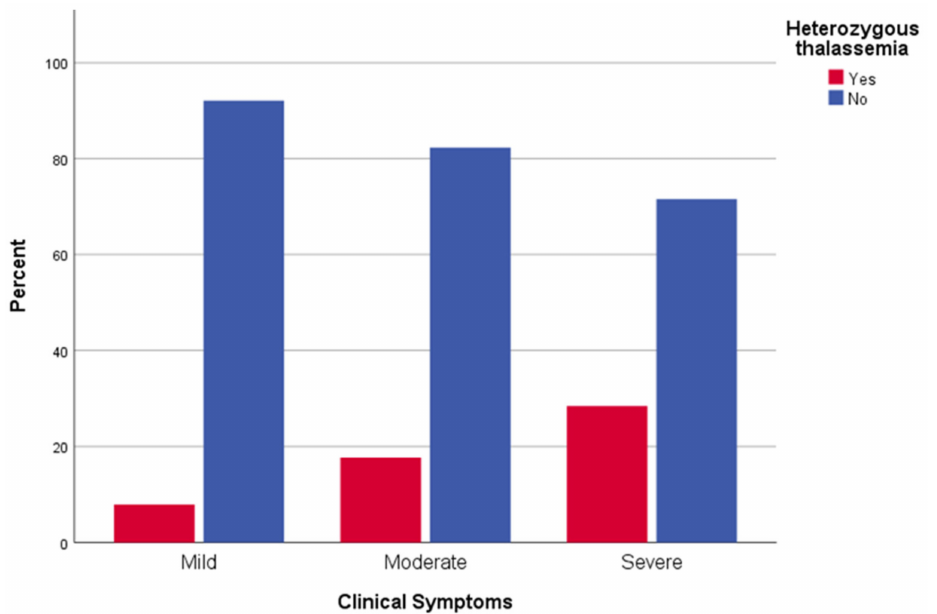
Figure 2. Clinical symptoms of COVID-19 in β -Thalassemia heterozygotes patients and control: distribution of clinical symptoms of SARS-CoV-2-infected β -Thalassemia trait carriers (red box) and non-carriers (blue